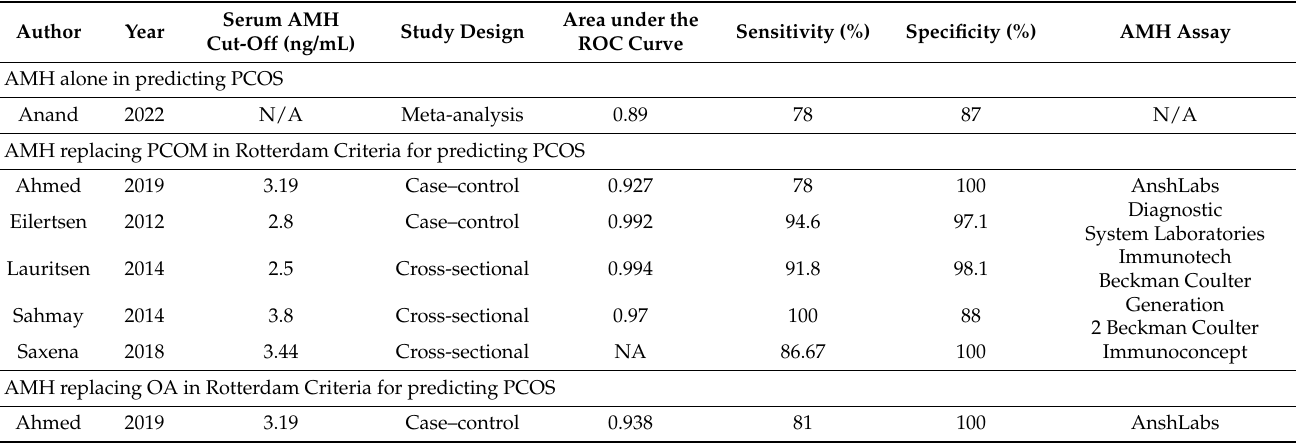
Table 1. Predictive value of AMH alone or AMH replacing polycystic ovarian morphology (PCOM) or oligo/amenorrhea (OA) for